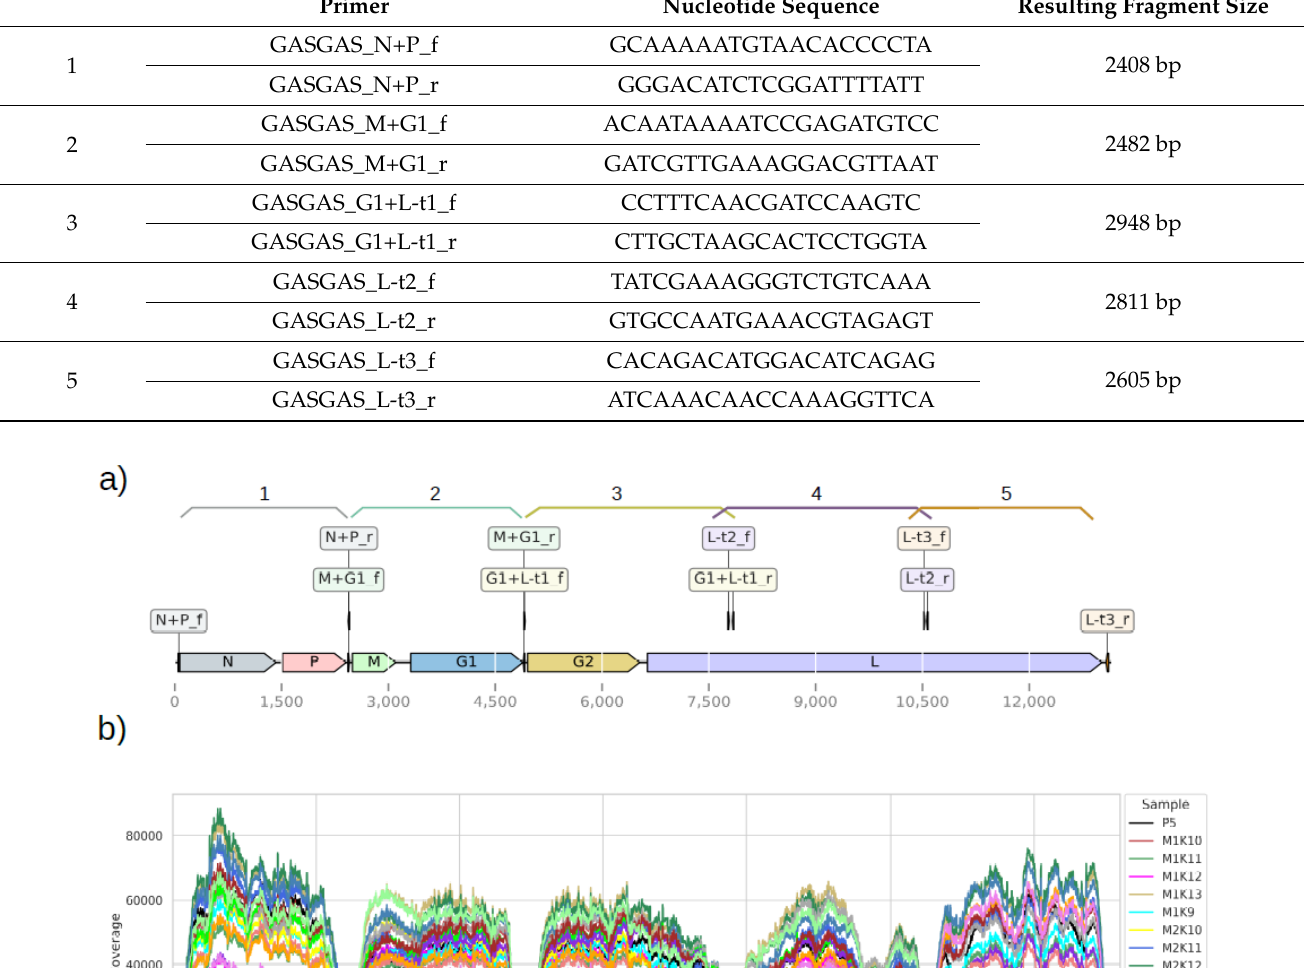
Figure 1. Genomic location of amplicons and variants. ( a ) Genome sequence of Rabies lyssavirus SPBN GASGAS strain and primer pairs used to generate amplicons (f — forward, r — reverse primer). The amplicons generated are indicated above according to numbering in Table 1. ( b ) Whole-genome read coverage for pooled 5th SMB passage (P5) sample and 17 SMB samples from passage 6 (MxKx — animal number). ( c ) SNP frequency in P5 and 17 individual SMB samples from passage 6. Positions, in which a change in consensus sequence occurred in at least one sample, are indicated above the given position together with the nucleotide and amino acid changes. The mutation intro- duced in SPBN GAGSAS strain, namely AAT [Asn] → TCC [Ser] (aa position 194) and AGA [Arg] → GAG [Glu] (aa position 333) are indicated by highlighting the middle nucleotide with “ × ”. 2.4.6. Gel Electrophoresis and Gel Extraction 25 µL of PCR product were separated in 1.2% agarose gels. The gels were stained with ethidium bromide before pictures were taken under UV light. The amplicons of in- terest were extracted with the Wizard SV Gel and PCR Clean-Up System (Promega, Mad- ison, WI, USA). The amplicons were eluted with 40 µL of molecular biology water (Lonza).